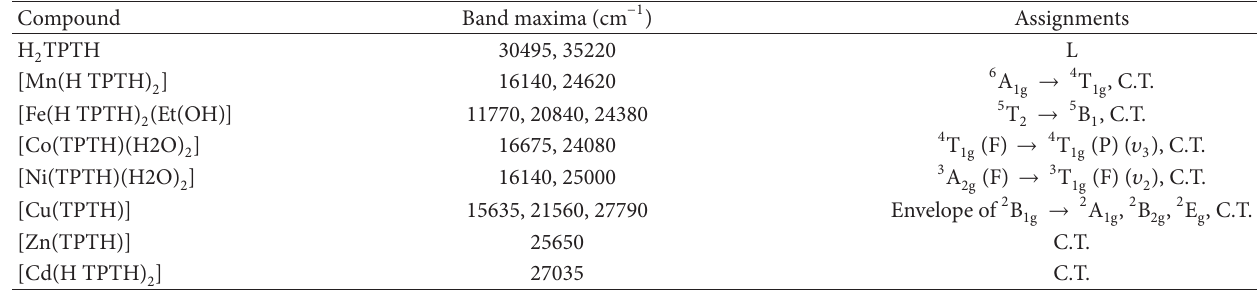
T 2: Electronic spectral bands and their assignments.